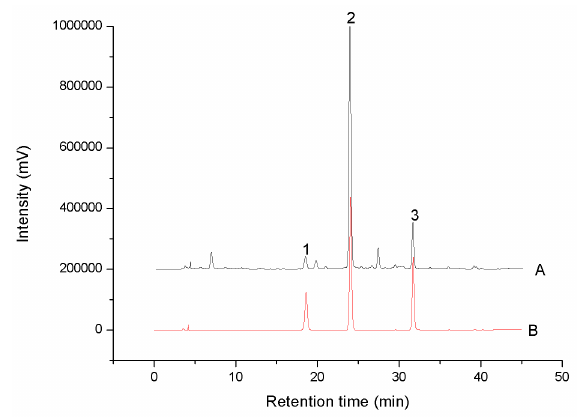
Figure 1: HPLC chromatograms of the sample of M. halliana flowers (A) and the standard solution (B). Peak 1: 3- hydroxyphloridzin; Peak 2: phloretin-4’- O -glycosidase; and Peak 3: afzeloside.